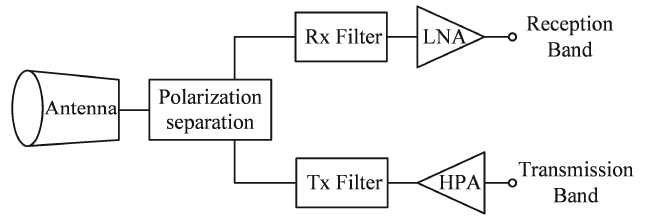
Figure 1. Electrical scheme of the antenna feed network in a typical SATCOM single-band terminal.